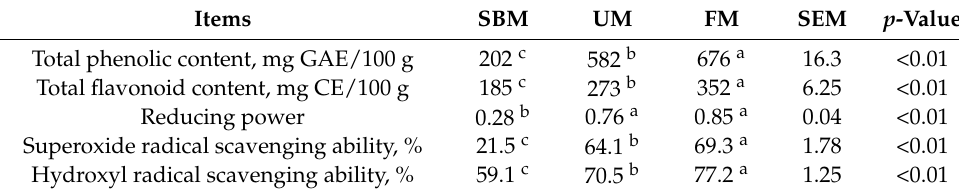
Table 3. Compared to control, UM and FM were higher in concentrations of C18:1 cis -9 ( p = 0.02) and C18:1 cis -11 ( p = 0.01), respectively. The concentrations of C22:4 and C22:5 Table 2. Total phenolic and flavonoid contents and in vitro antioxidant activity of soybean meal n-3 in UM and FM were lower than in control ( p = 0.01). Other fatty acid compositions did (SBM), and unfermented (UM) and fermented yellow wine lees mix (FM). not differ across the three Items SBM UM FM SEM p -Value Total phenolic content, 202 c 582 b 676 a 16.3 <0.01 mg GAE/100 g Total flavonoid content, 185 c 273 b 352 a 6.25 <0.01 mg CE/100 g Reducing power 0.28 b 0.76 a 0.85 a 0.04 <0.01